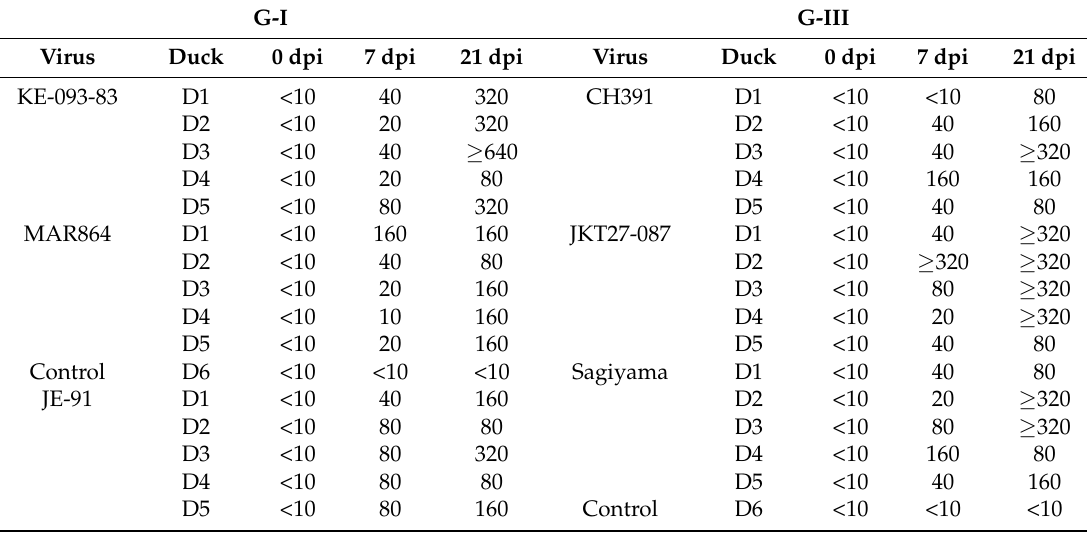
Table 2. Plaque Reduction Neutralization Test antibody titer in ducklings inoculated with Japanese encephalitis viruses (90% cut